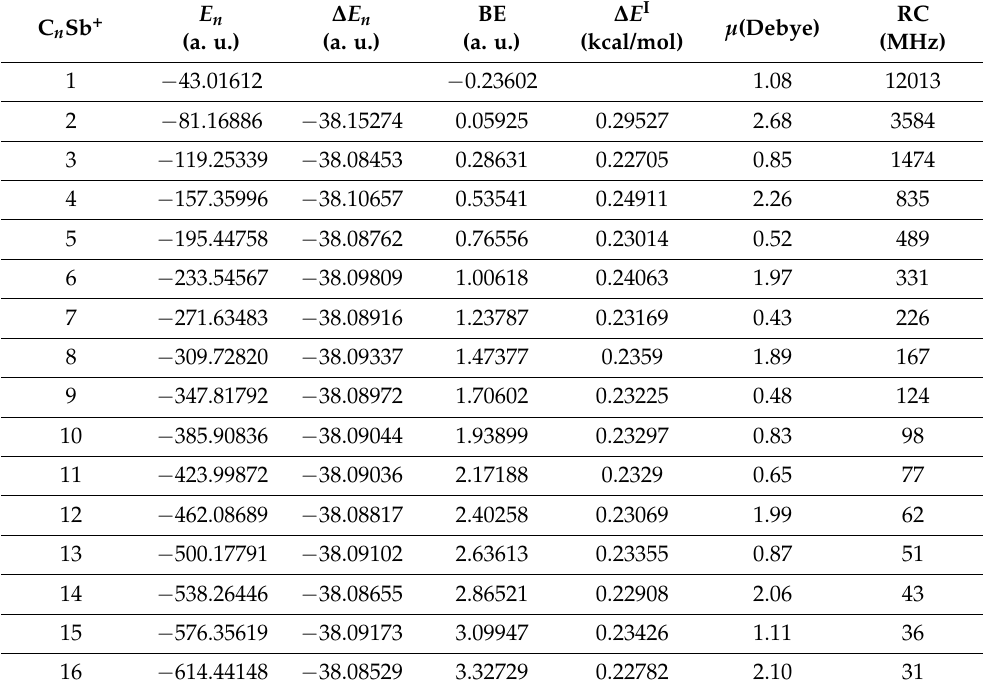
Table 5. The total energies E n , differential energies ∆ E n , incremental energies ∆ E I , binding energies